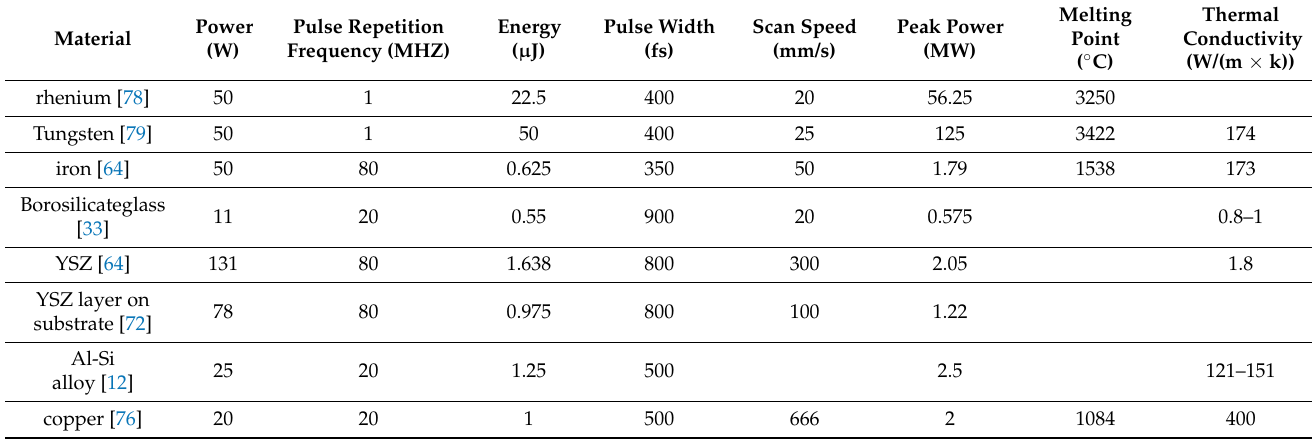
Table 2. The suitable ultrashort pulse laser processing parameters and material